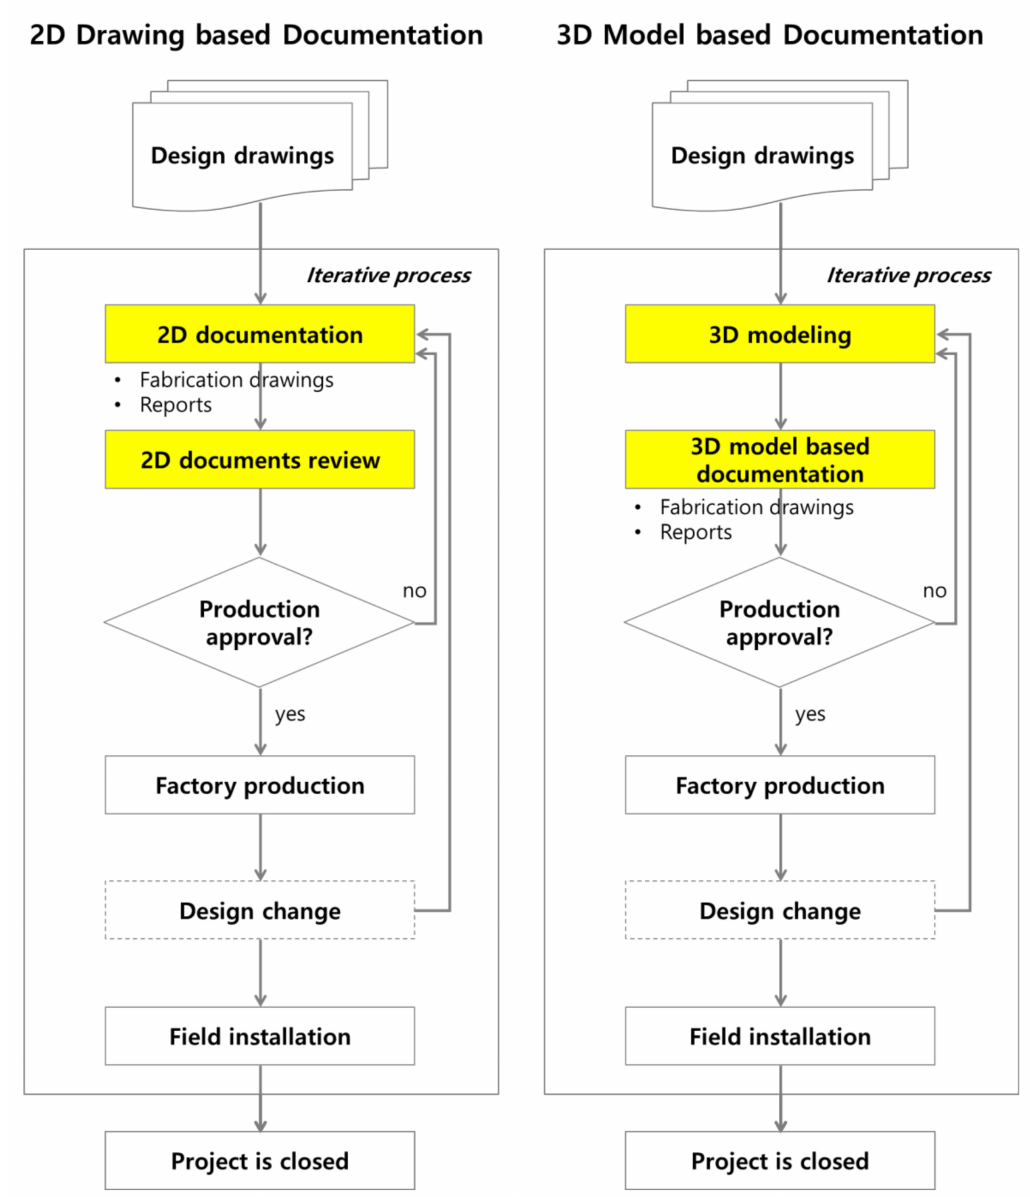
Figure 3. Detailed process of 2D-drawing-based documentation and 3D-model-based